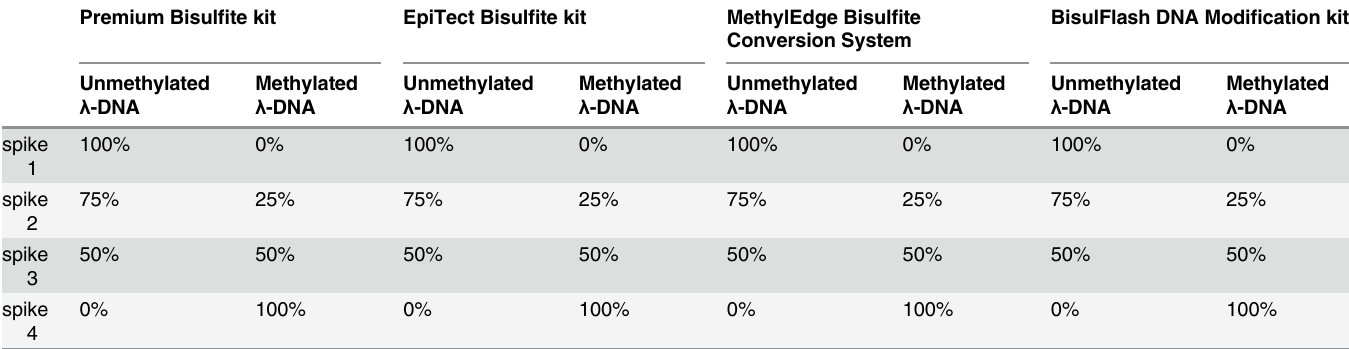
Table 1. PCR amplicons that were used for bisulfite conversion and sanger